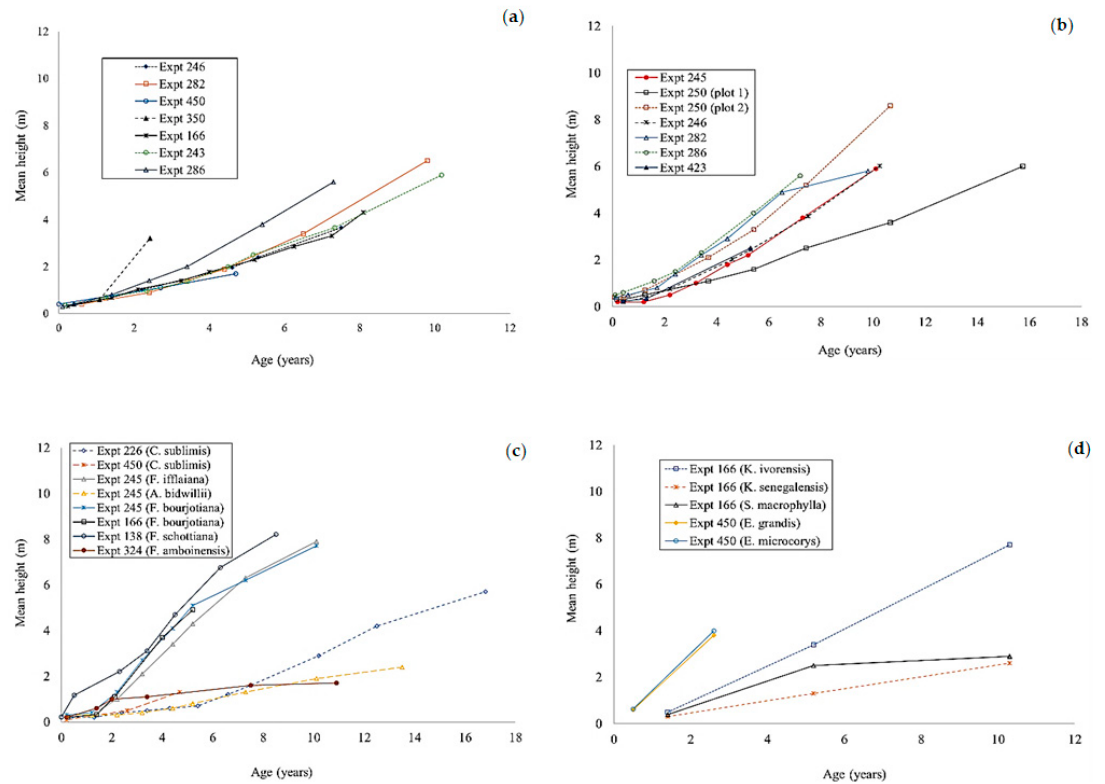
Figure 5. The height growth of Araucaria cunninghamii ( a ); Agathis robusta ( b ); Cardwellia sublimis, Araucaria bidwillii, Swietenia macrophylla, Flindersia bourjotiana, Flindersia schottiana, Flindersia i ffl aiana, and Flindersia amboinensis ( c ); Khaya ivorensis, Khaya senegalensis, Eucalyptus grandis, and Eucalyptus microcorys ( d ) in enrichment planting experiments in north Queensland. Plot 1 of experiment 250 was planted with the southern provenance of Agathis